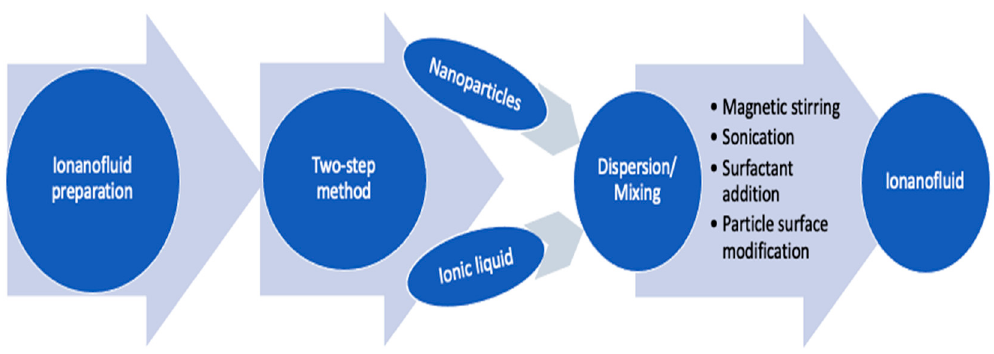
Figure 1. Schematic of concept of ionanofluids preparation.